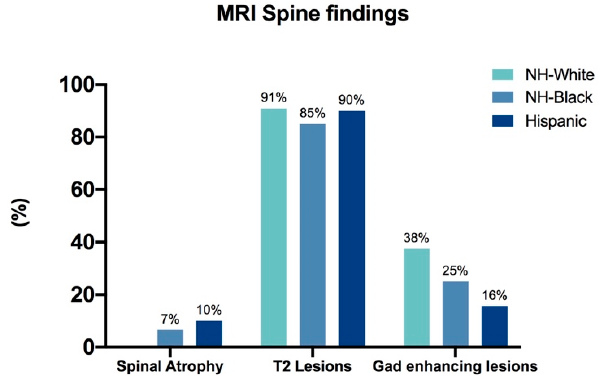
Figure 2. The total percentage of patients in each group who had spinal atrophy, T2, or gadolinium- enhancing lesions in the spine as determined by MRI findings at diagnosis. Only patients who had MRI scans on file were included in this analysis. p = 0.6974, p = 0.5128, p = 0.2957 for comparison of total percentage of patients in each group that had spinal atrophy, spinal T2 lesions, and spinal gadolinium-enhancing lesions respectively (Fisher’s exact).